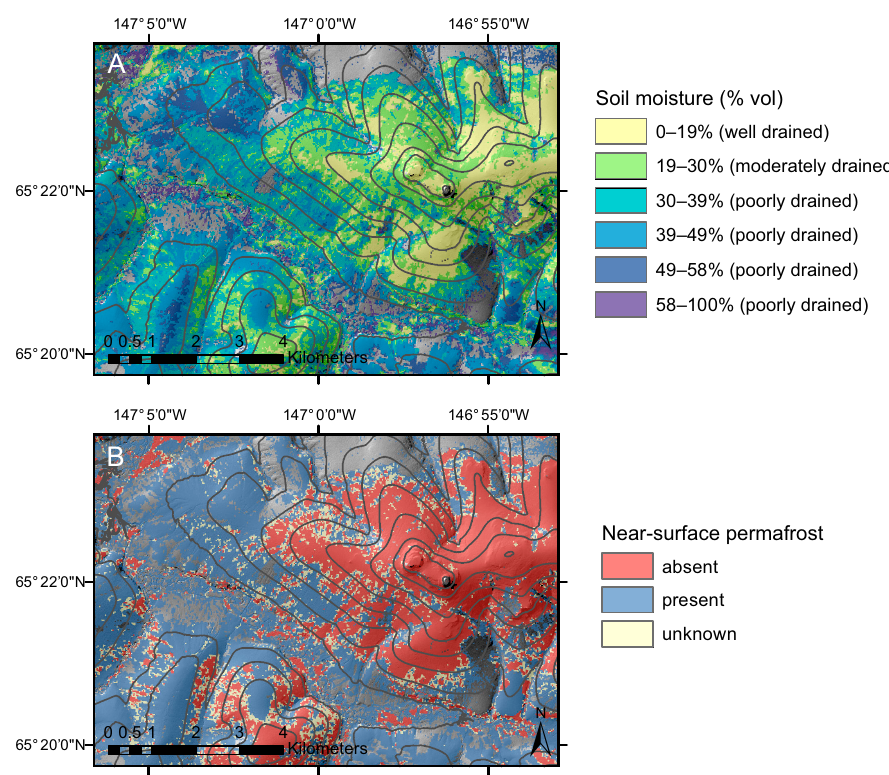
Figure 8. Maps of ( A ) soil moisture (% vol) of upper 20 cm and ( B ) near-surface permafrost (~1 m) distribution a decade after the 2004 Boundary Fire in interior Alaska with 50-m contour lines overlain on a DEM. Thematic maps are based on NDII7 calculations from a Landsat 8 OLI scene acquired 9 September 2014. Unburned areas are